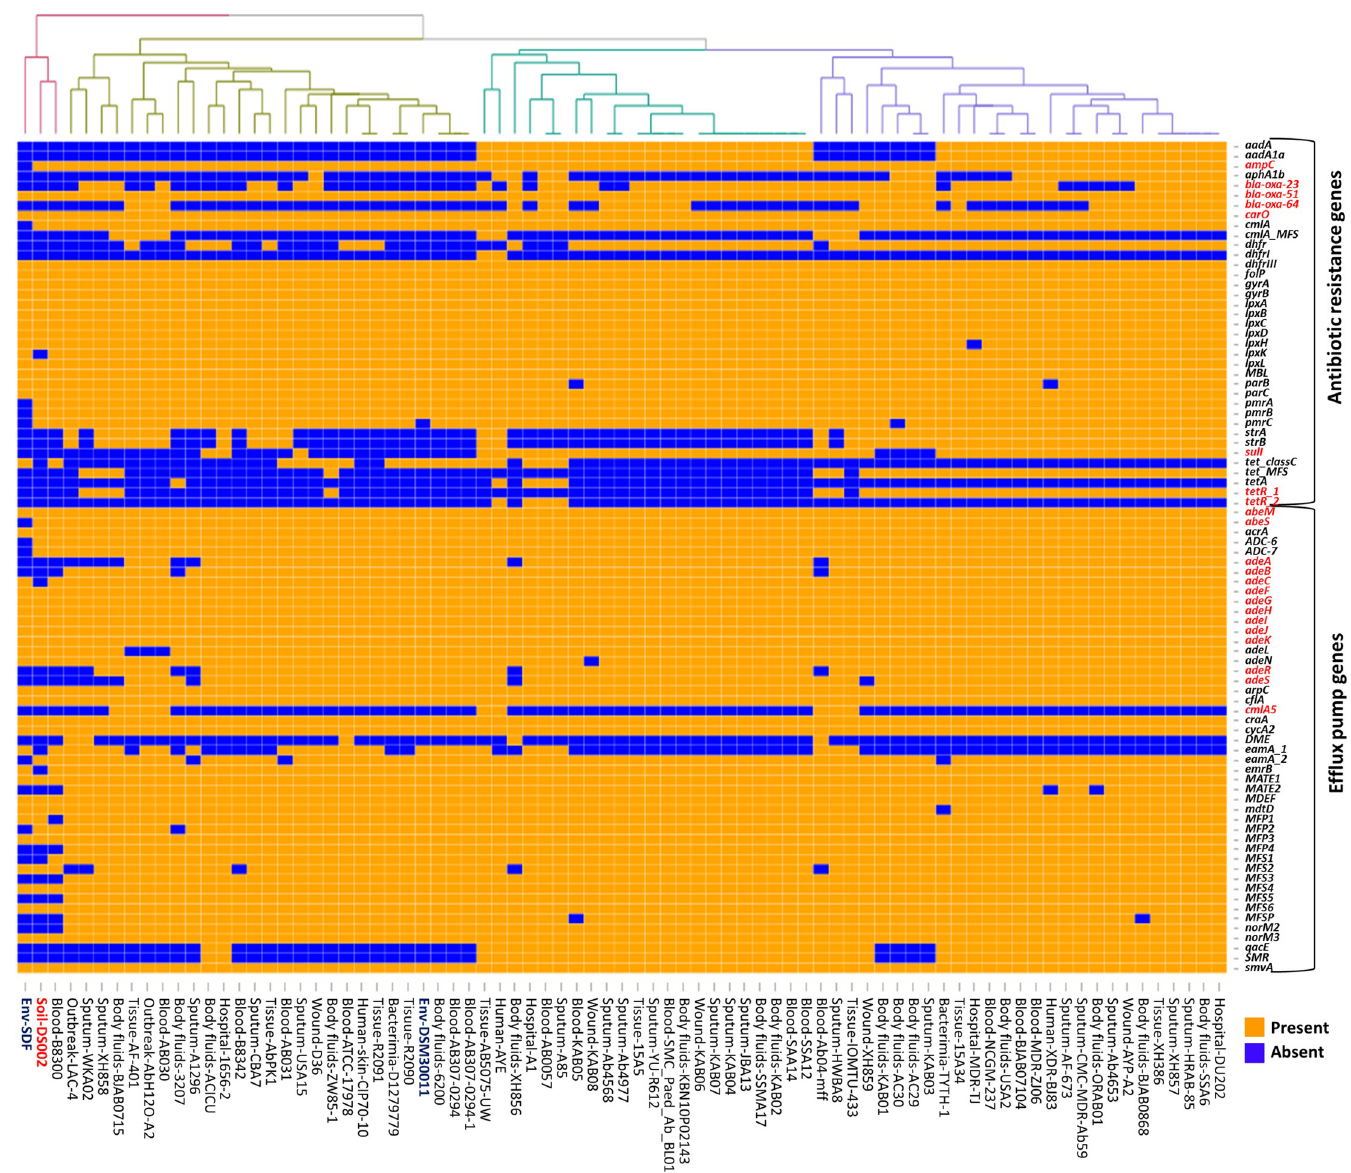
Fig 6. Heat map showing LS-BSR analysis of genes involved in resistance. Genes extensively discussed in the text as well as the strain DS002 are highlighted in red font.